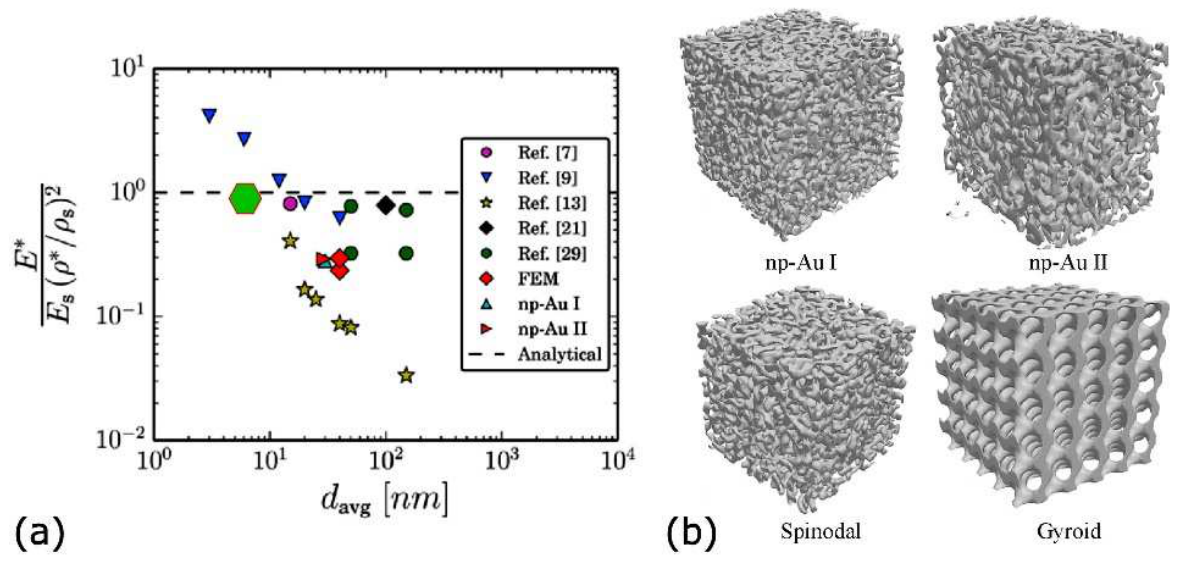
Figure 11. ( a ) Variation of normalized modulus of nanoporous gold with average ligament diameter. The dashed line represents the C E = 1 value. The currently discussed Ag case appears as the green hexagon. ( b ) Renderings of the reconstructed nanoporous gold structures, the computationally generated spinodal structure, and the mathematical gyroid structure. Adapted from ref. [19] .